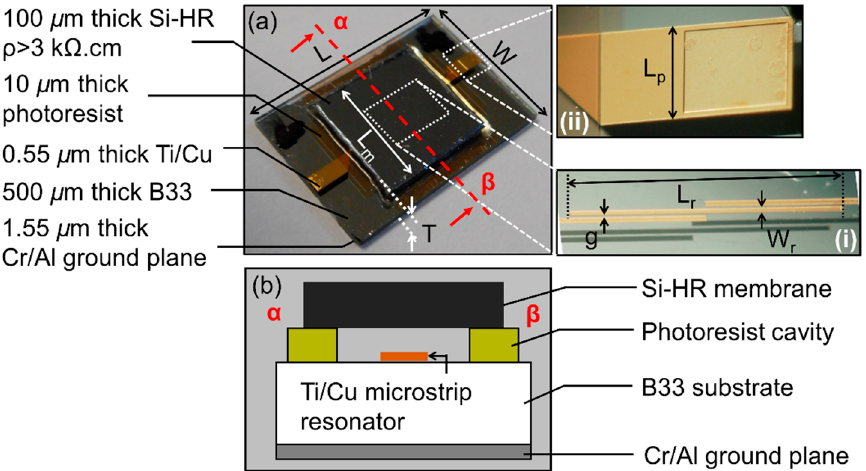
Table 4. Dielectric parameters of sensor materials.